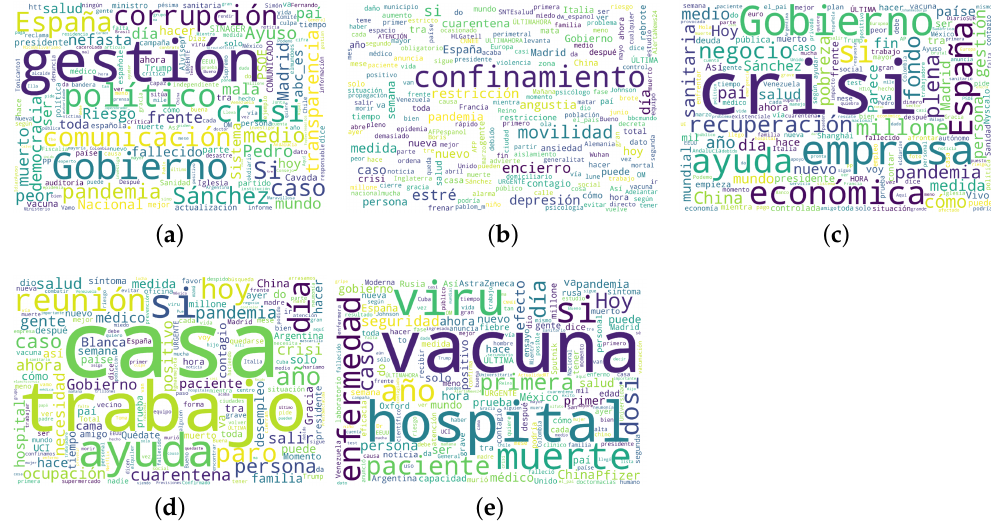
Figure 2. Word clouds per topic: ( a ) government; ( b ) health; ( c ) economic; ( d ) employment; ( e )